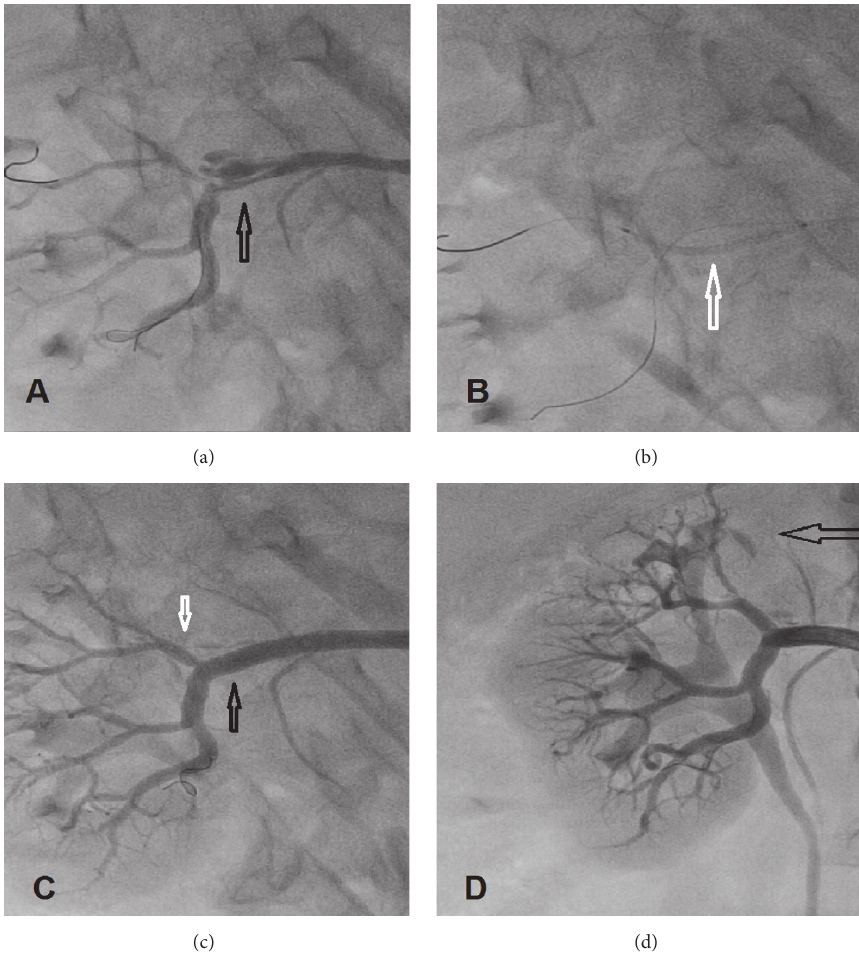
Figure 3: Renal artery treatment. (a) 0.014 󸀠󸀠 coronary wire crossing the true lumen (arrow), (b) 2 wires, one in the upper lobar branch and one in the lower branch with balloon dilation of the main trunk into the upper branch (white arrow), (c) stenting of the upper branch (white arrow) and the main branch into the lower branch (black arrow), and (d) final image showing the posttreatment results. Dark open arrow points to the infarcted upper lobe of the right kidney where dye opacification is